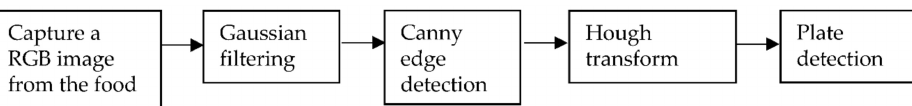
Figure 5. The plate detection using Hough